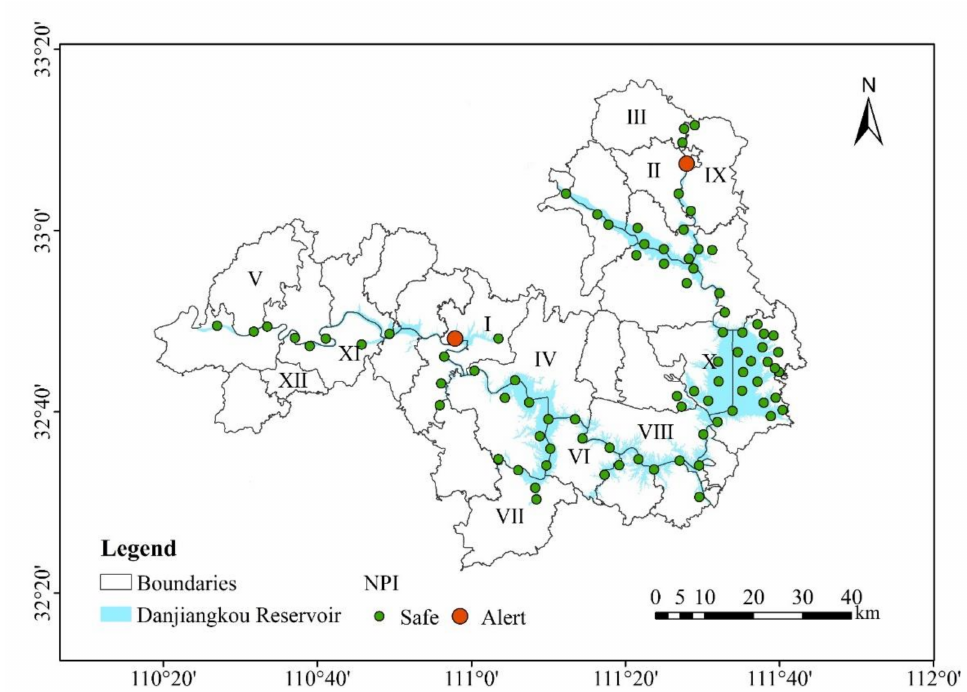
Figure 3. Spatial distribution of NPI for six heavy metals in surface water of study area. I: Anyang Town; II: Jinhe Town; III: Maotang Town; IV: Xijiadian Town; V: Hejia Town; VI: Longshan Town; VII: